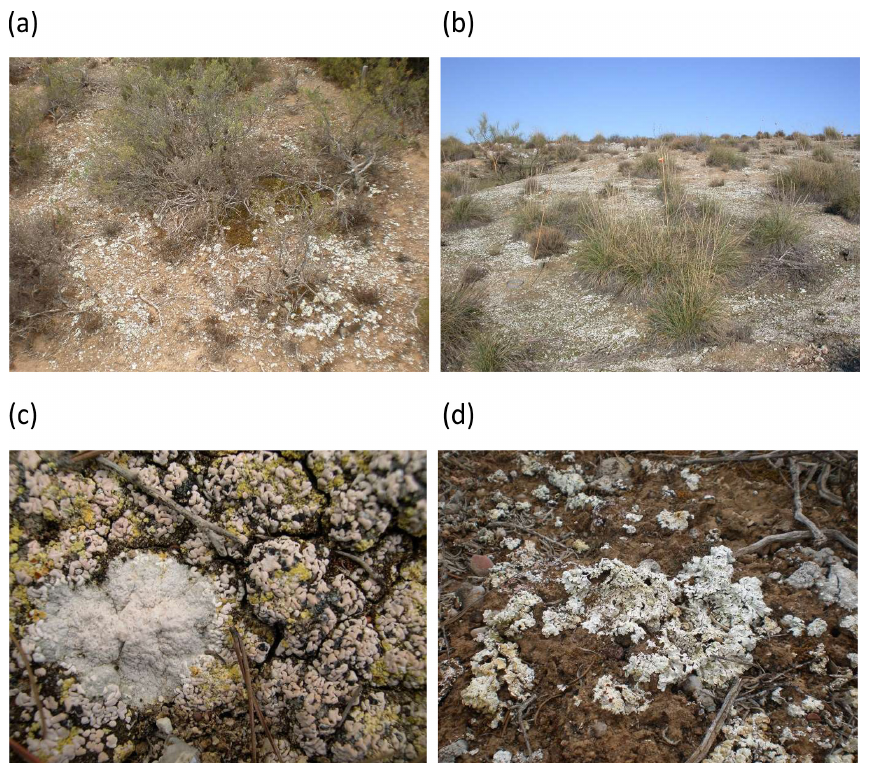
Figure 15. Examples of semi-arid shrublands (a) and steppes (b) , showing the dominance of biocrusts in plant interspaces. Close-up views of biocrust communities dominated by lichens are shown in (c) and (d) , respectively. Photographs by Fernando T. Maestre.